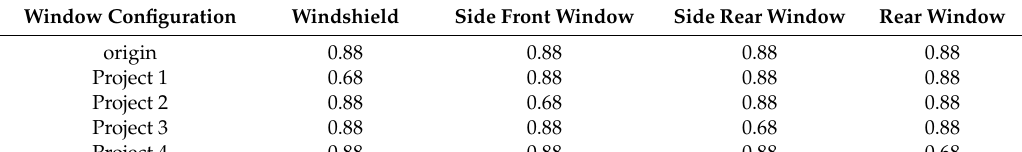
Table 6. Setting glazing transmissivity in di ff erent windows.